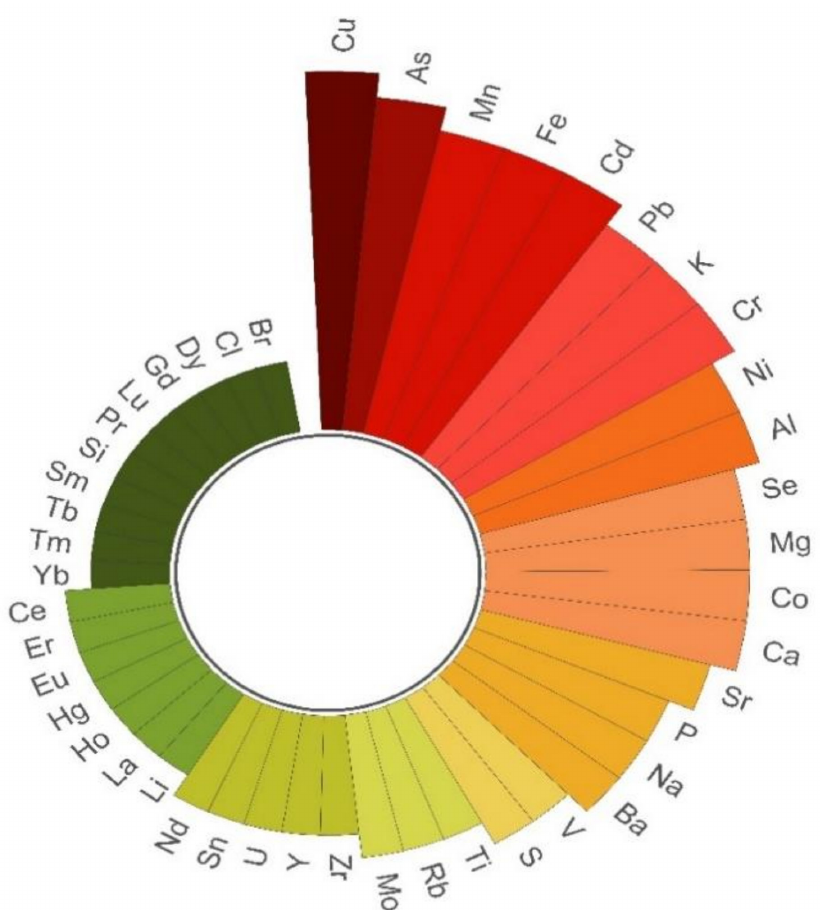
Figure 1. Radial bar chart showing the most widely used elemental markers in the works from the last 10 years dealing with authenticity and traceability of fish and seafood products. Data were elaborated from the scientific literature (published in 2010–2020) and collected from the Scopus and Web of Science search engines, using ‘fish,’ ‘seafood,’ ‘authentication,’ ‘elemental analysis,’ ‘elemental profile,’ ‘elemental fingerprinting,’ and/or ‘chemometrics’ as search